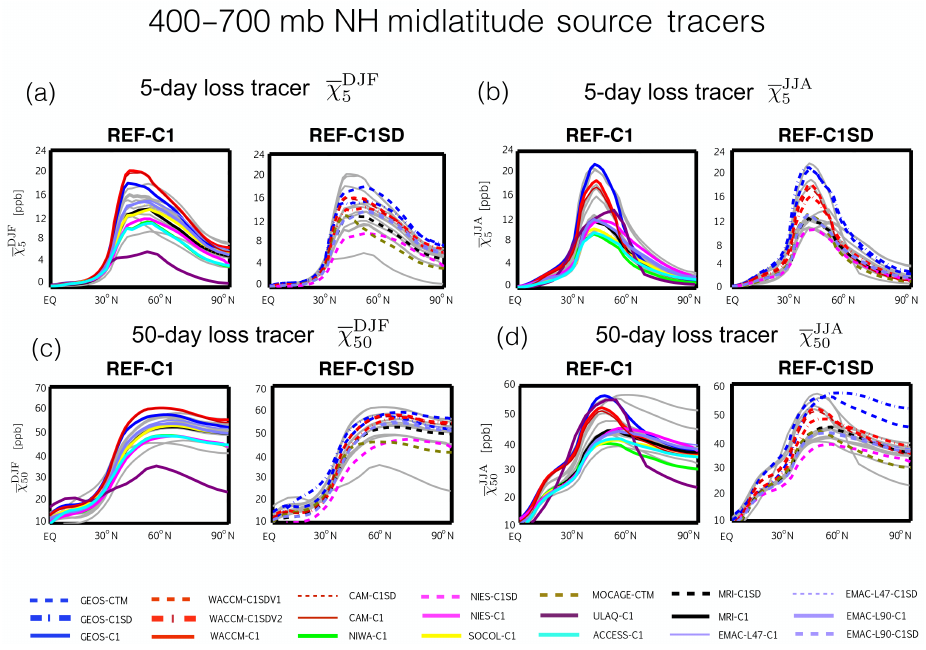
Figure 2. Meridional profiles of the 400–700hPa zonally averaged DJF (a, c) and JJA (b, d) 5-day and 50-day loss tracers, χ 5 and χ 50 . Dashed lines in panels (b, d) correspond to the REF-C1SD simulations, which are constrained with analysis meteorological fields, while solid lines in panels (a, c) correspond to the free-running REF-C1 simulations. Grey solid lines in each panel correspond to the REF-C1SD and REF-C1 simulations in panels (a, c) and (b, d) , respectively. Note that the x axis only spans the Northern